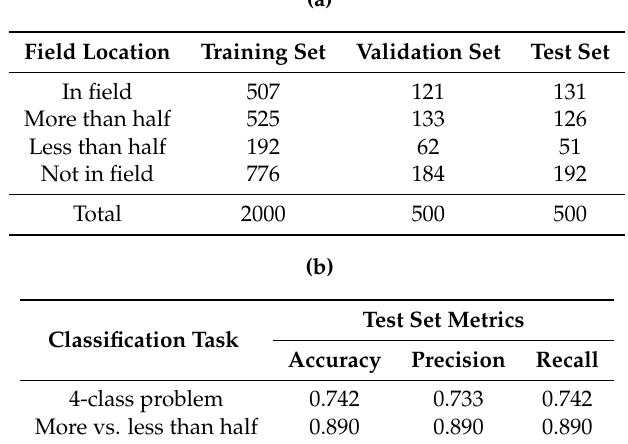
Table 2. Sentinel-2 pixel in-field classification using DigitalGlobe imagery. ( a ) Label distribution for the training, validation, and test images used to train and evaluate the VGG and ResNet models. ( b ) Classification accuracy, precision, and recall for the 4-class task and a simpler binary task (more than half vs. less than half in